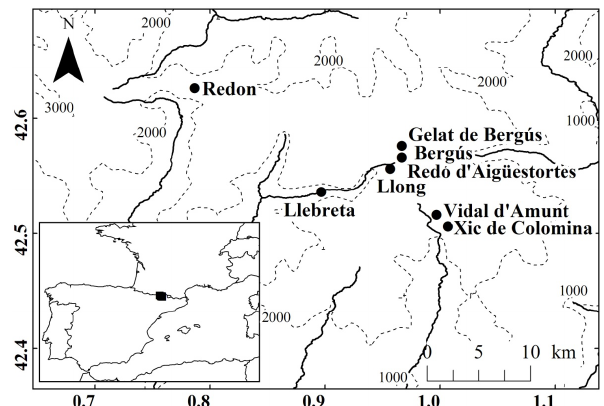
Fig. 1. Map showing the location of the eight lakes in the “Aig¨uestortes i Estany de Sant Maurici” National Park, Central Pyrenees